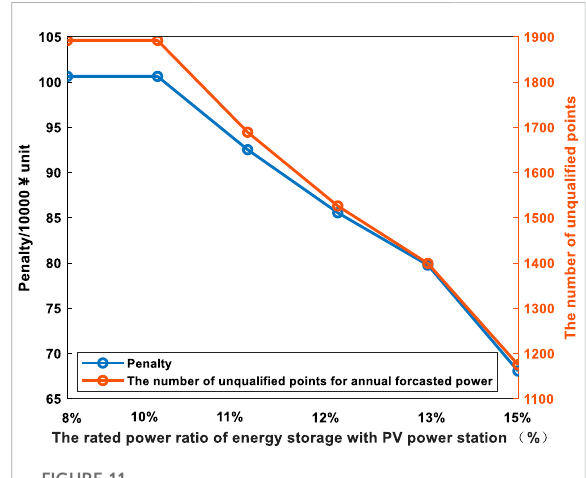
FIGURE 9 Solar curtailment rate and net income with different power ratios.